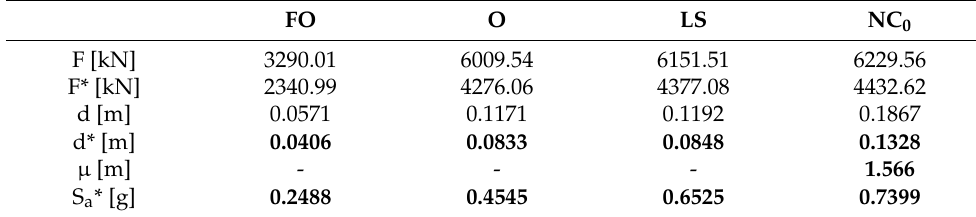
Table 8. Nassar and Krawinkler approach (SCBF).